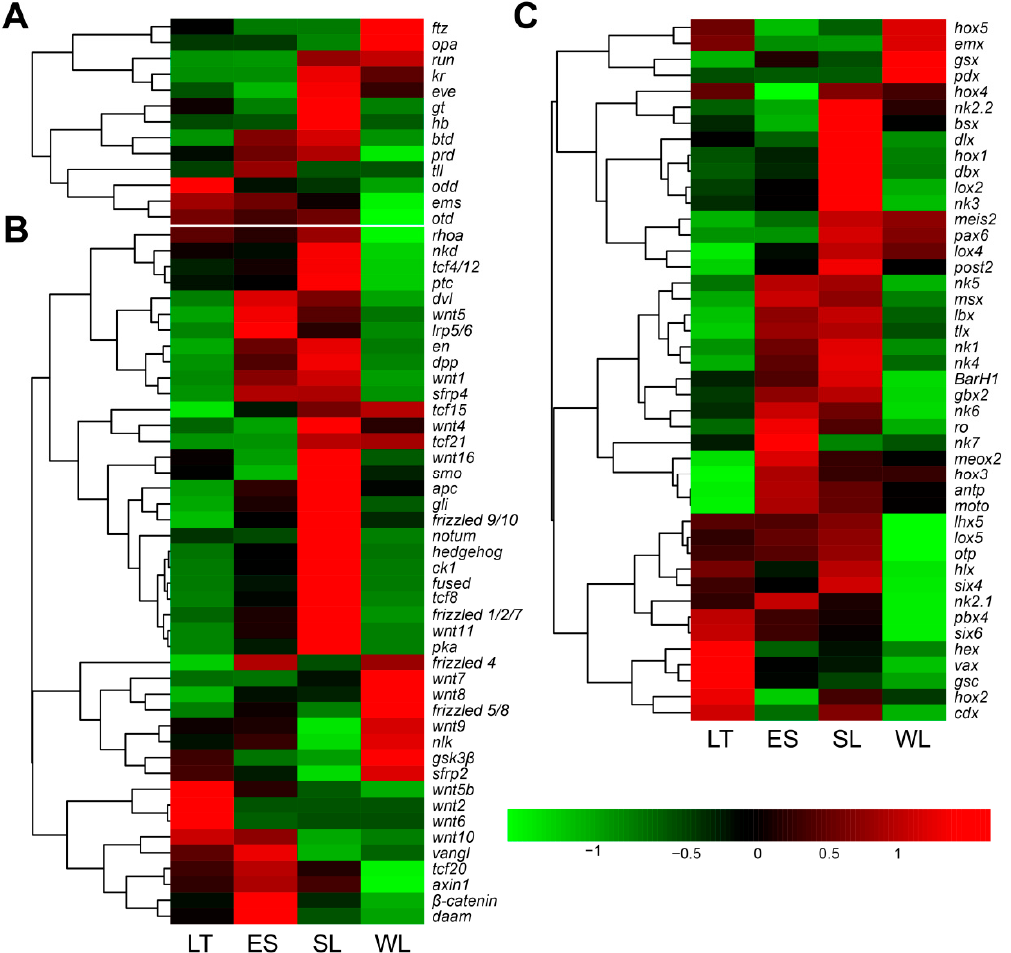
Figure 6. Hierarchical clustering of the segment formation homologous genes in U. unicinctus larval transcriptome. ( A ), Gap genes and pair-rule genes; ( B ), segment polarity genes; ( C ), homeotic genes. The clustering indicates similar expression patterns among the genes. The expression levels of genes are presented in the color tape from low (green) to high (red).